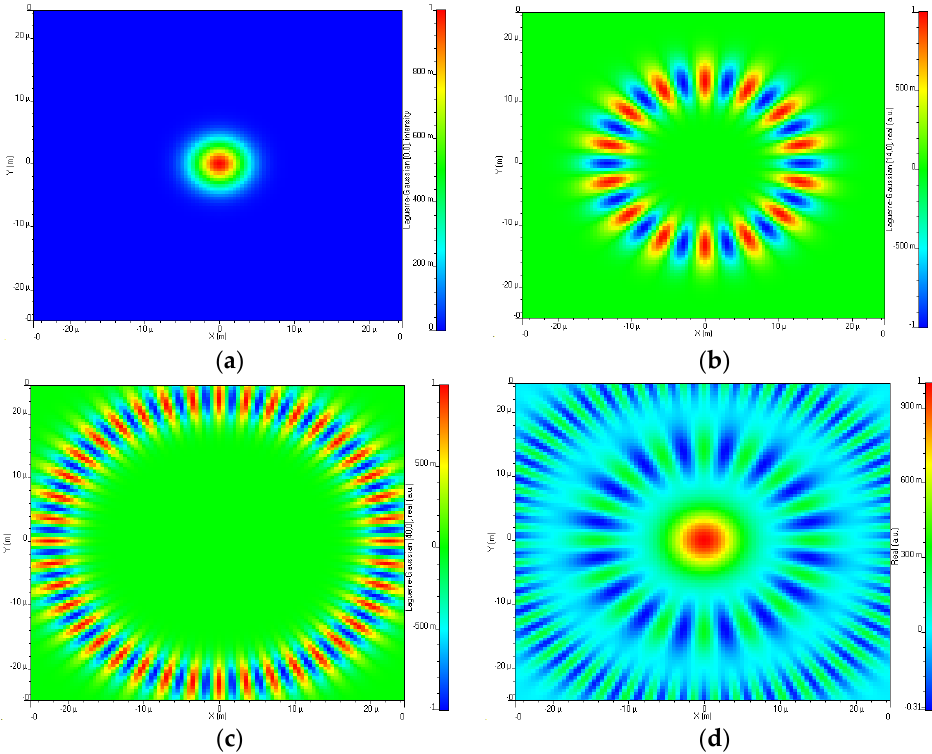
Figure 8. Transverse mode profiles ( a ) LG0,0, ( b ) LG14,0, ( c ) LG40,0, and ( d ) OAM multiplexed beams.